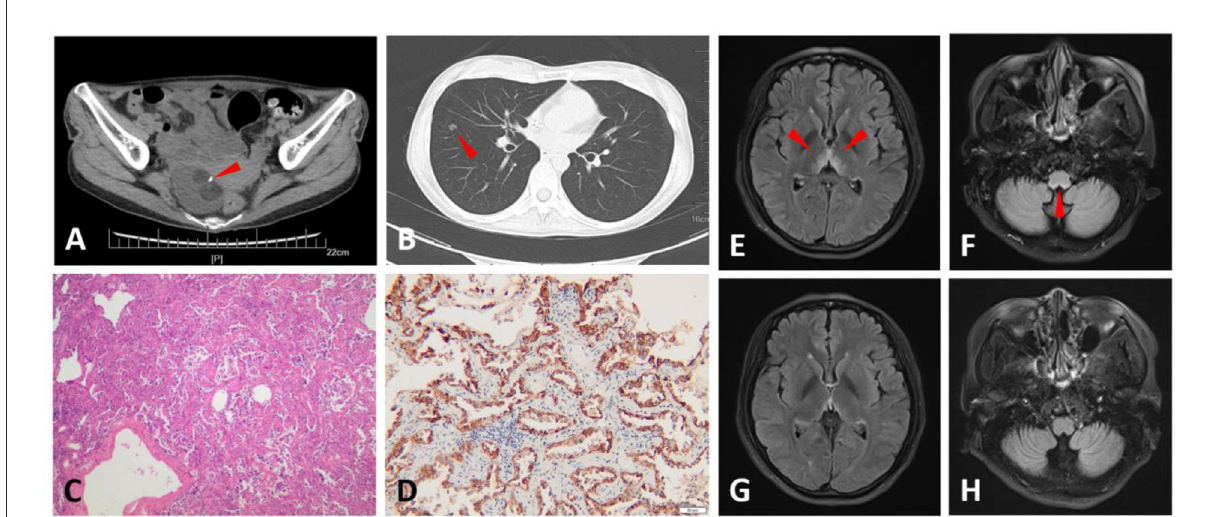
FIGURE1 Computed tomography (CT), magnetic resonance imaging (MRI), and pathological findings of Case 1. An abdominal CT scan shows a tumor in the right ovary, in which calcification and fat were observed, and suggests an ovarian teratoma (arrowhead) (A) . Chest CT scan shows a nodule (9mm in diameter) in the right lung (arrowhead) (B) . Hematoxylin and eosin (H&E) staining of the lung nodule section indicates adenocarcinoma (C) . The lung nodule section stained with aquaporin-4 (AQP-4)-specific monoclonal antibody (sc-32739, Santa Cruz, United States of America) shows intense immunoreactivity on adenocarcinoma cells (D) . Fluid-attenuated inversion recovery (FLAIR) images of the brain display hyperintense symmetrical lesions in the thalamus, hypothalamus (E) , and area postrema (F) when the patient was first present in our department (arrowhead). These lesions disappeared 6 months later (G,H) .